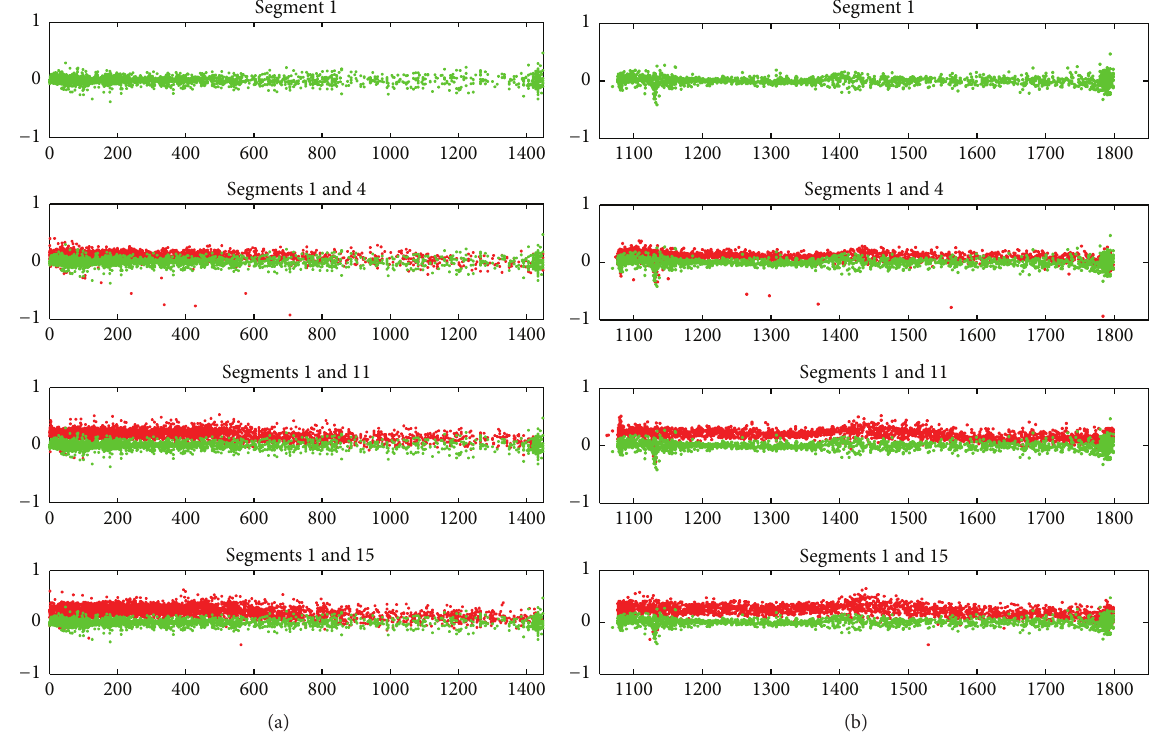
Figure7:RegressionofPPestimationerroronsegment1(green)andselectedfollowingsegments(red)infunctionofpower(a)androtational speed (b).